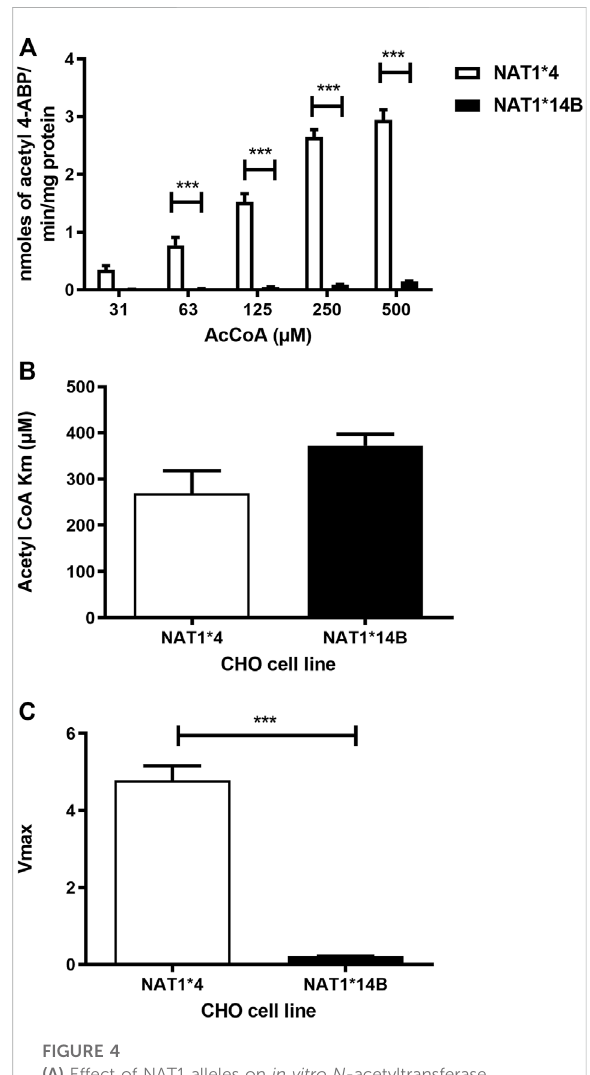
FIGURE 4 (A) Effect of NAT1 alleles on in vitro N -acetyltransferase catalyticactivitiestowards4-ABP usingAcCoA A 31.3 – 500 µM. (B) Apparent AcCoA K m did not signi fi cantly differ between both alleles. (C) V max (nmol/min/mg) was signi fi cantly higher in NAT1*4 compared to NAT1*14B . Data represents Mean ± S.E.M.